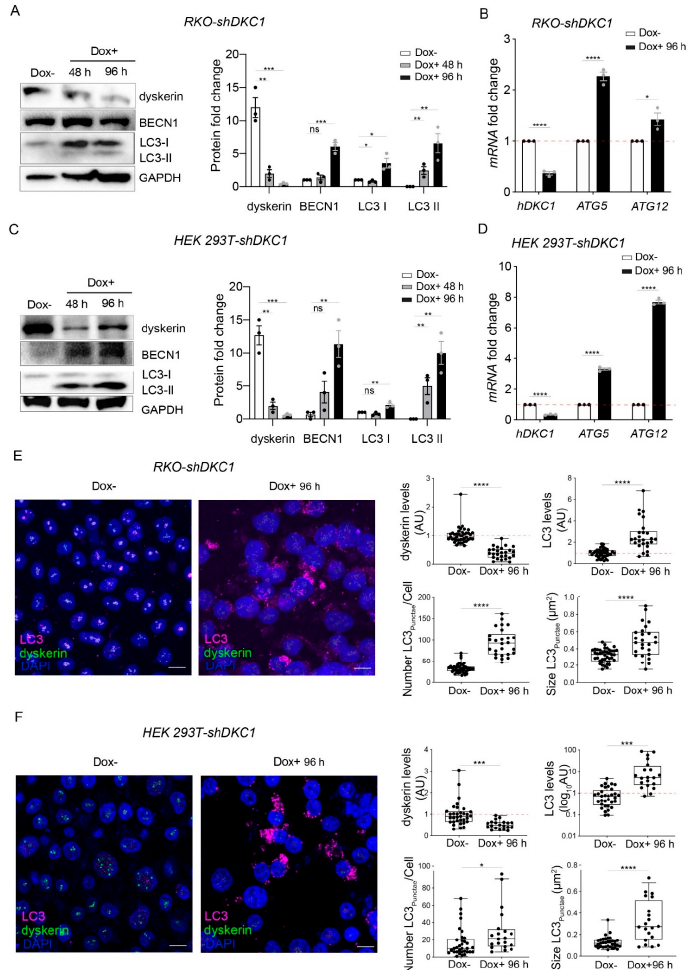
Figure 4. Dyskerin downregulation induces a set of autophagic markers. ( A , C ) Western blot analyses of BECN1 and LC3 proteins following 48 or 96 h of dyskerin depletion. Dyskerin depletion induces LC3-II in both RKO-shDKC1 ( A ) and HEK 293T-shDKC1 ( C ) silenced cells (Dox+). Upon silencing, LC3-I, whose level is not indicative of autophagic induction, also appeared upregulated in RKO cells. BECN1 levels increased in both cellular systems at the times considered. Protein levels were normalized to GAPDH. Results are expressed as mean ± SEM ( n = 3). ( B , D ) qRT-PCR analyses in both RKO-shDKC1 and HEK 293T-shDKC1 (( B , D ), respectively) cells show an increase in the transcription of ATG12 and ATG5 genes, which participate in the elongation of autophagosomes, following 96 h of Dox-induced dyskerin silencing. Results are expressed as mean ± SEM ( n = 3). ( E , F ) Confocal micrographs of control (Dox–) and silenced (Dox+) RKO-shDKC1 ( E ) and HEK 293T-shDKC1 ( F ) cells, immunolabeled with anti-LC3 (magenta) and anti-dyskerin (green) antibodies. Scale bars 10 µ m. Nuclei were counterstained with DAPI. LC3 and dyskerin levels were quantified in multiple cells ( n = 42 RKO-shDKC1 Dox–; n = 26 RKO-shDKC1 Dox+ 96 h; n = 33 HEK 293T-shDKC1 Dox–; n = 20 293T HEK 293T-shDKC1 Dox+ 96 h), normalized and reported relative to the Dox– condition as mean ± SEM. The cytoplasmic LC3 puncta number and size were also calculated for the same cells. Both LC3 puncta and size were significantly upregulated after 96 h of Dox treatment. An unpaired one-tailed t -test was used in pairwise comparisons with respect to the Dox– condition in all statistical analyses in this figure (**** p < 0.0001; *** p < 0.001; ** p < 0.01; * p < 0.05; ns, p >